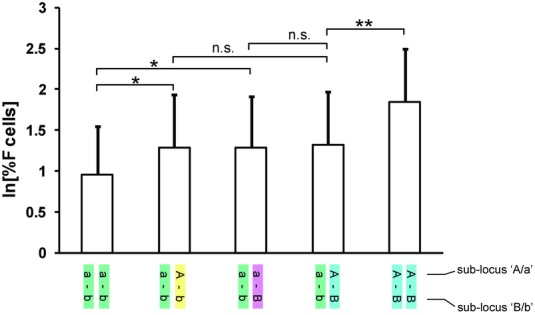
Fetal haemoglobin persistence (%F cells) in Europeans stratified by HMIP-2 genotype. The European cohort was chosen, because of its size (n = 3800), to compare genotypic trait values (mean + SD) for individuals carrying different haplotype combinations.Carrying a single HbF-promoting allele (second and third column) significantly boosts HbF persistence, compared to having none (first column). The effects of “A” and “B” alleles appear similar. Carrying a “double-hit” chromosome (“A–B” haplotype) does not further increase trait values when present in heterozygous form. In comparison, homozygotes have significantly increased F cell levels. Genotypic values for HbF persistence in the twins were measured as “% F cells,” the proportion of red blood cells carrying HbF. This is equivalent to “% HbF” but better suited to nonanemic subjects, where %HbF values are below the dynamic range for the standard HPLC detection method.*P < 0.005; **P < 0.0001; n.s., not significant.A one-tailed t-test was used for comparing the genotype groups, i.e., to confirm/reject the findings in the patients, i.e., an HbF-increasing effect of the “A” and “B” containing haplotypes.